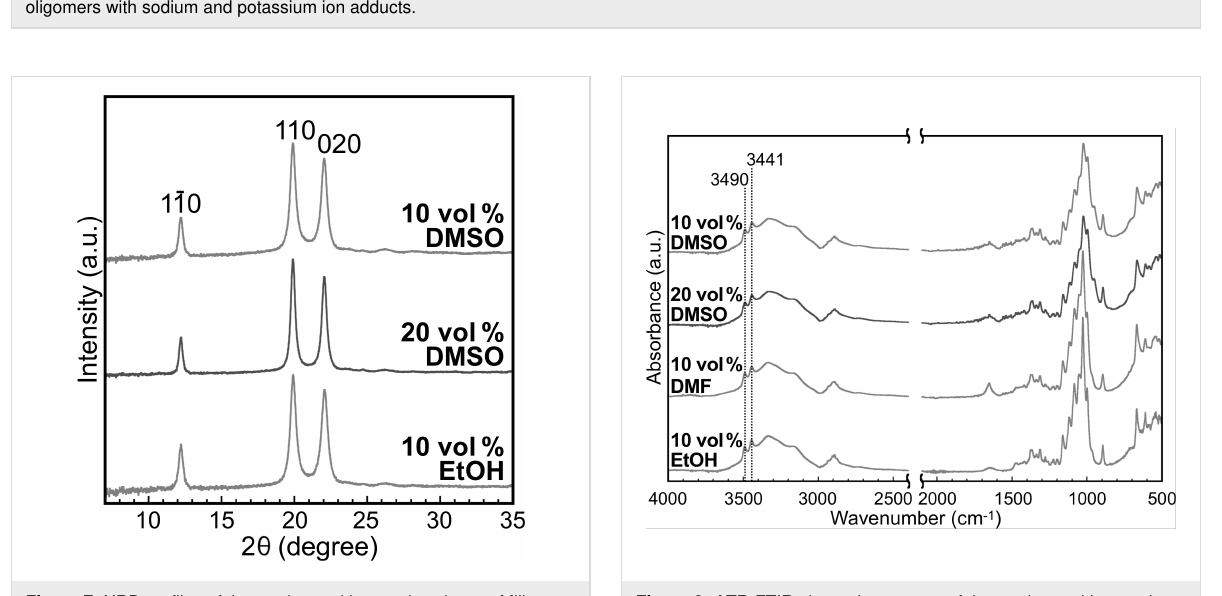
Figure 7: XRD profiles of the products with organic solvents. Miller indices for cellulose II are shown above the peaks.